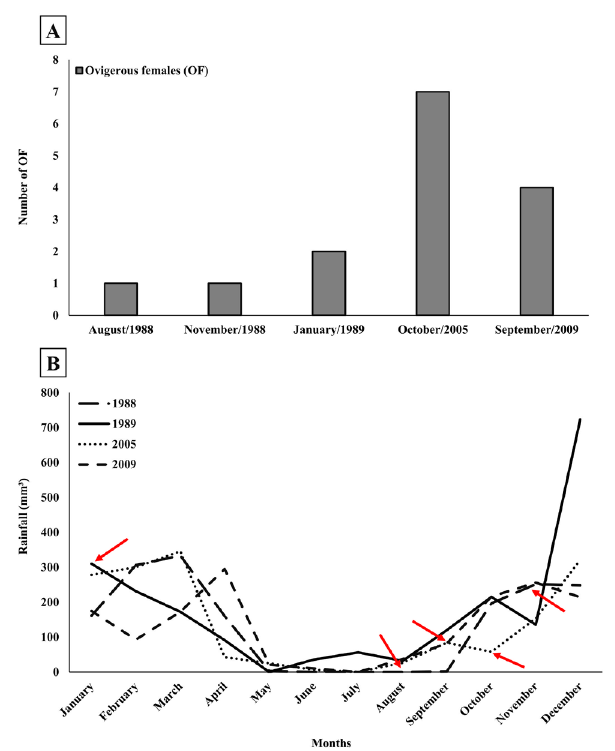
Figure 4. Macrobrachium candango Mantelatto, Pileggi, Pantaleão, Magalhães, Villalobos and Álvarez, 2021. A . Number of ovigerous females obtained during the collection period. B . Monthly rainfall variation in the years when ovigerous females were found (1988, 1989, 2005, and 2009). Red arrows indicate in which months the ovigerous females